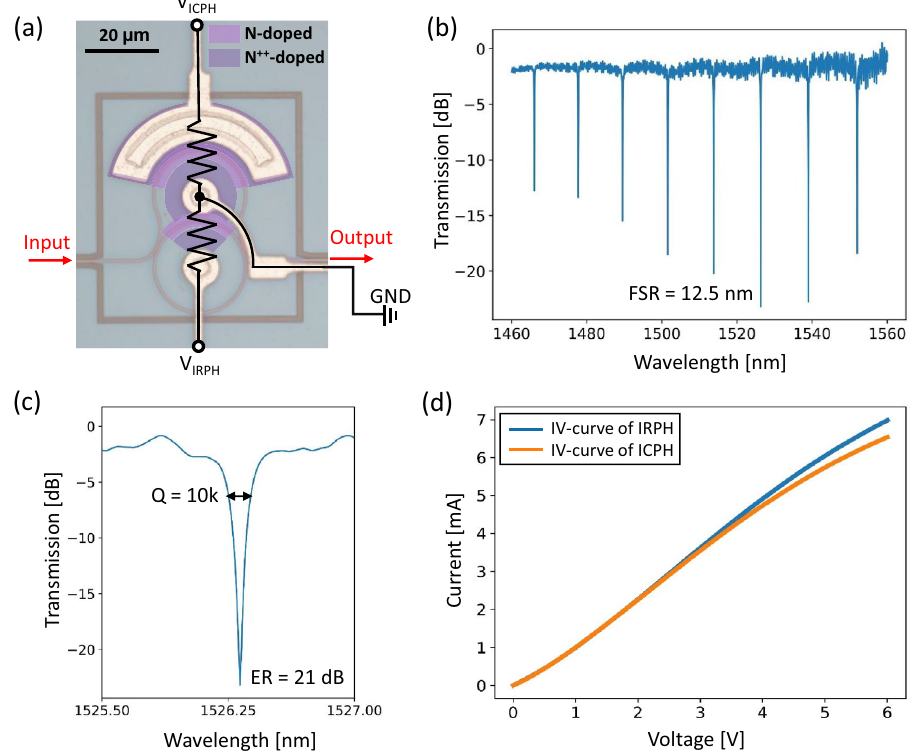
Figure 2. ( a ) Microscopic image of the all-pass IM-MRM design overlaid with a circuit description of the integrated ICPH and IRPH. ( b ) Measured transmission spectrum of the fabricated IM-MRM after normalization, showing a doubled FSR. ( c ) A closer look at the resonant peak at 1526.25 nm. ( d ) Measured IV curves for integrated ICPH and IRPH with voltages varying from 0 to 6